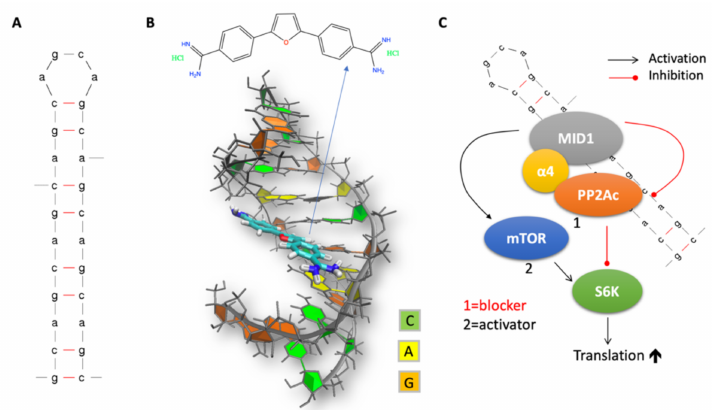
Figure 2. ( A ) CAG RNA hairpin 2D structure. ( B ) CAG RNA hairpin 3D structure in complex with furamidine, as obtained from Reference [17]. ( C ) Scheme of MID1-dependent aberrant translation. MID1 recruits translation regulator proteins including PP2A and S6K to CAG RNA hairpin structures, thereby promoting their translation. MID1-dependent translation initiation is mediated by the opposing activities of PP2A and mTOR on